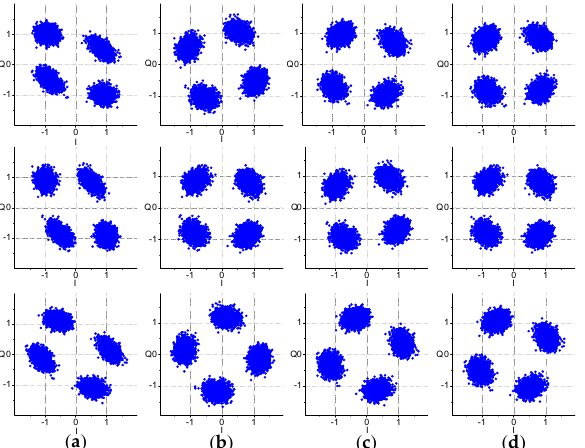
Figure 7. ( a ) Initial constellation; ( b ) after the GSOP; ( c ) after the SYOP; ( d ) after the ASOP.